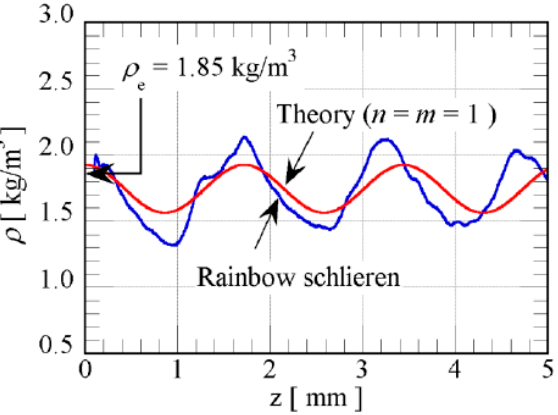
Figure 32. Rainbow Schlieren post-processing density contour plot. Reprinted with permission from Ref. [45] (2018).